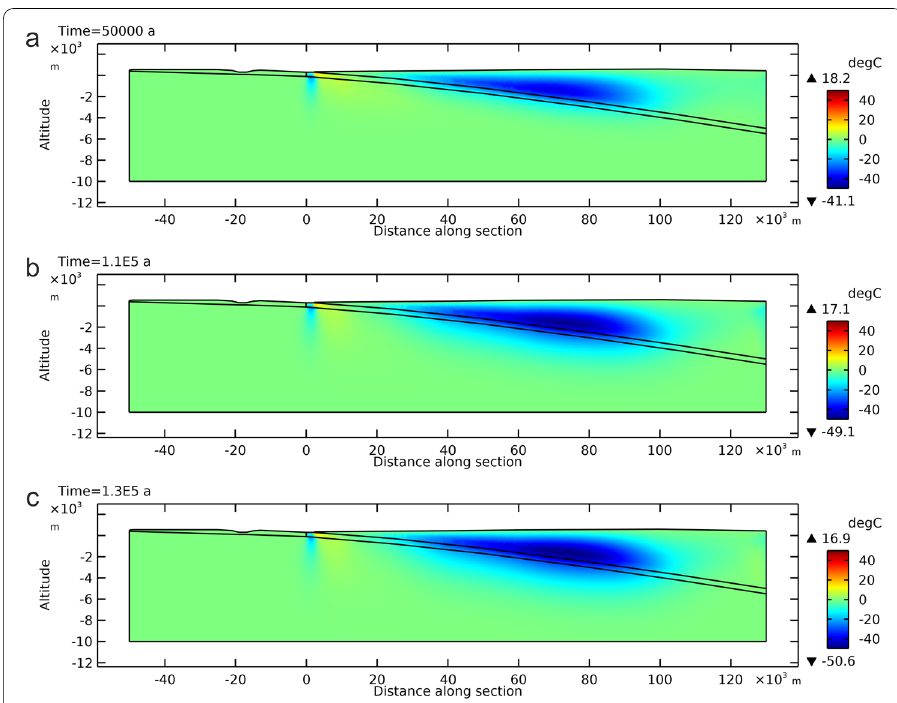
Fig. 15 Temperature difference between both scenarios of high and low Malm permeabilities with a constant surface-temperature condition (i.e. difference between model runs G and F introduced in Fig. 3): a 80 ka ago (time 50,000 a), b 20 ka ago (time 1.1E5 a), and c at present (time 1.3E5 a). Vertical = = = exaggeration equals